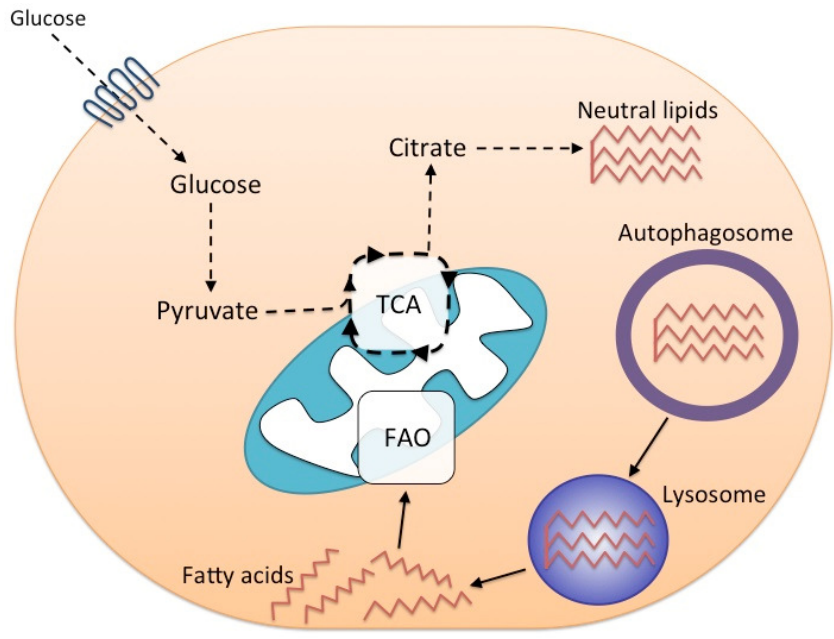
FIGURE 2: Autophagy and fatty acid metabolism are important for memory CD8 + T cell formation . During